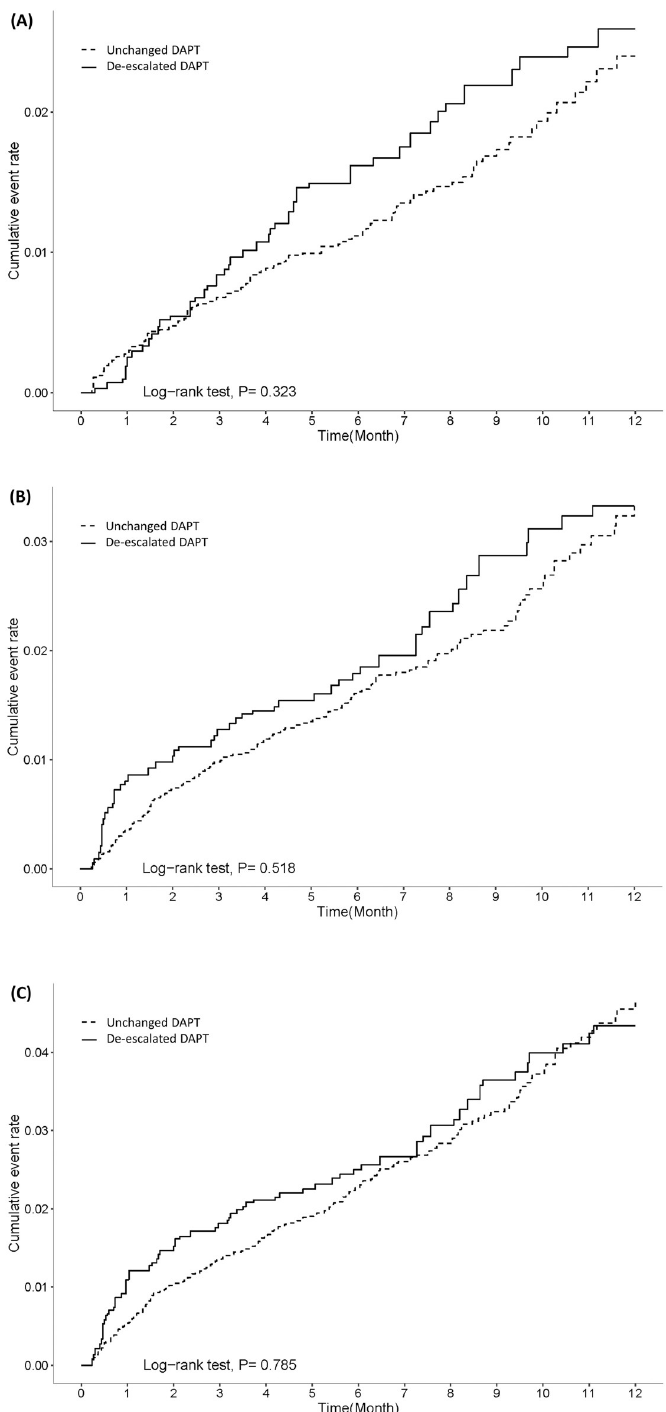
Fig 2. Kaplan-Meier curves along with adjusted hazard risk for efficacy outcomes between unchanged and de- escalated groups. A) all cause death. B) AMI readmission. C) MACE.